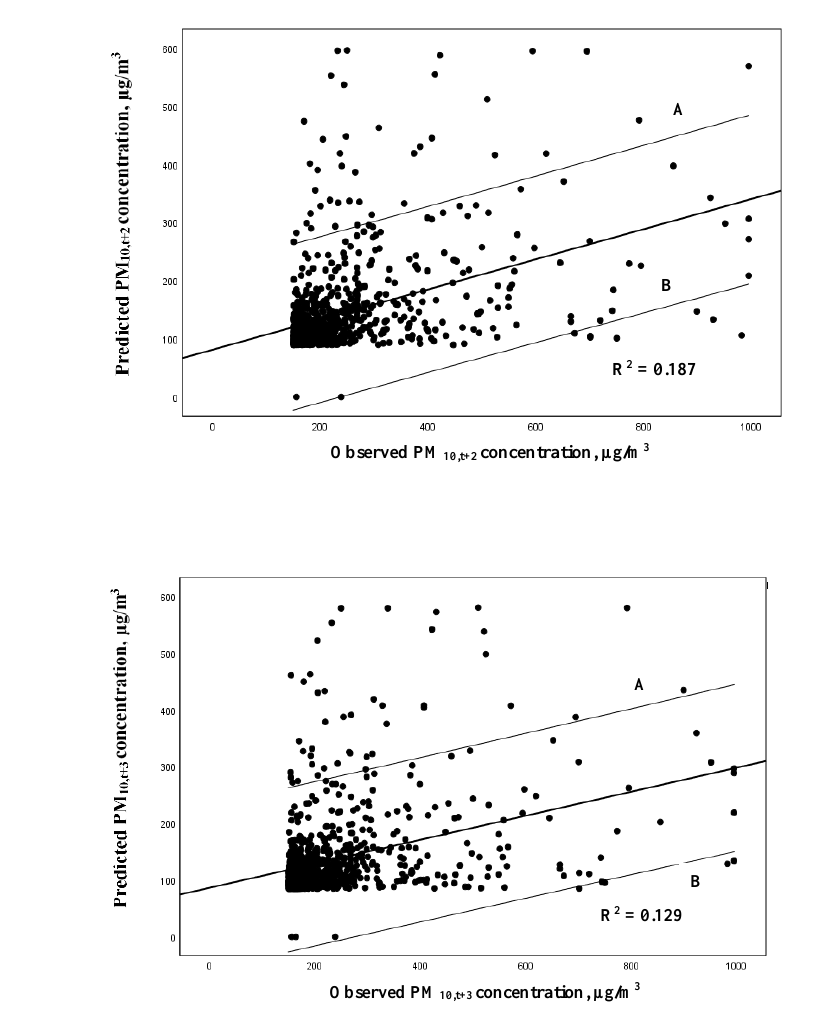
Figure 3. Scatter plot of predicted PM 10 concentration ( µ g / m 3 ) against observed PM 10 concentration ( µ g / m 3 ) for ( a ) PM 10,t + 1 model, ( b ) PM 10,t + 2 model, and ( c ) PM 10,t + 3 model.